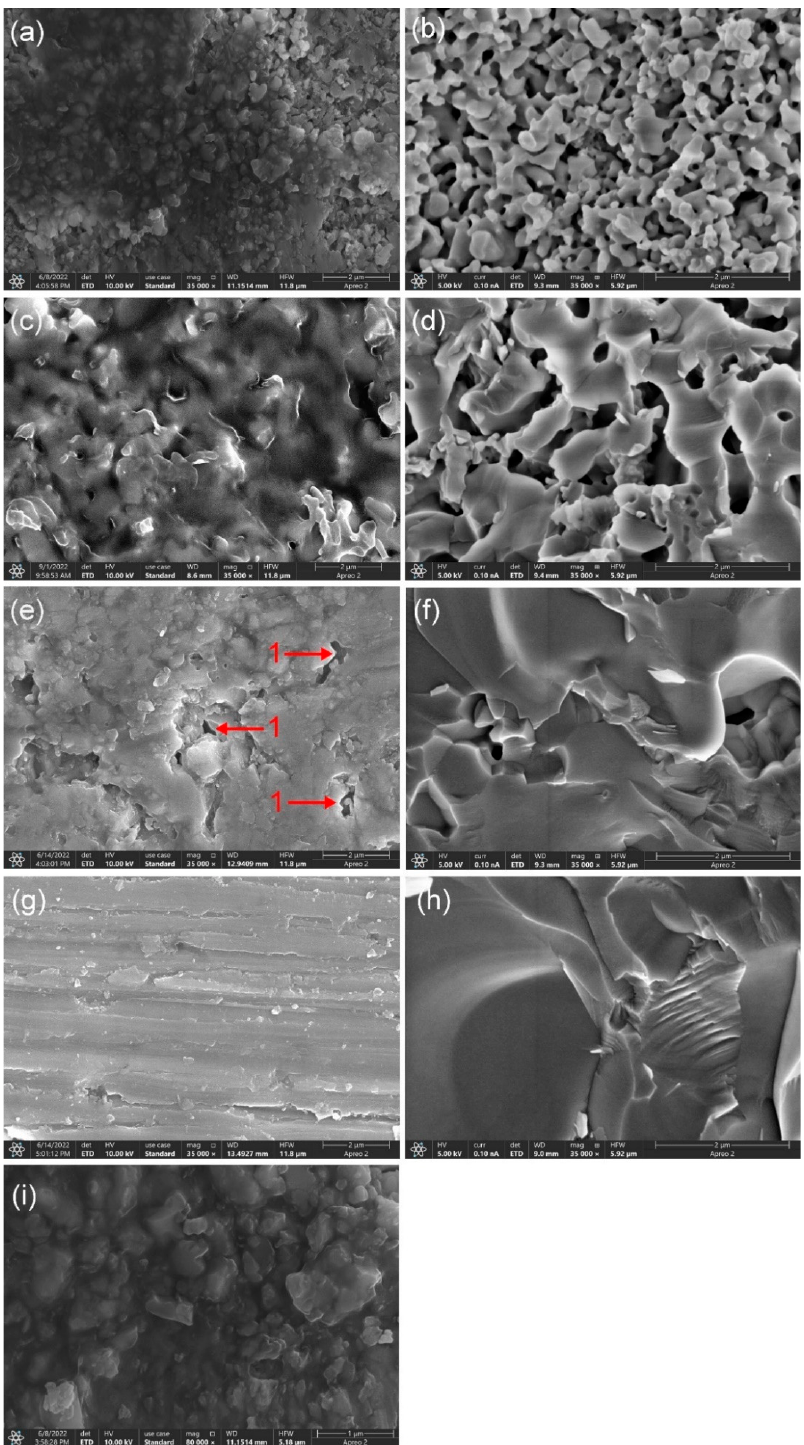
Figure 3. FESEM images of fracture surfaces of specimens with different sintering temperatures: ( a , b , i ) 1000 °C; ( c , d ) 1100 °C; ( e , f ) 1200 °C; ( g , h ) 1300 °C; ( a , c , e , g , i ) specimens after monomer mixtures’ infiltration and curing; ( b , d , f , h ) ceramics; arrow 1 in ( e ) closed pores; ( i ) enlarged view of ( a ).